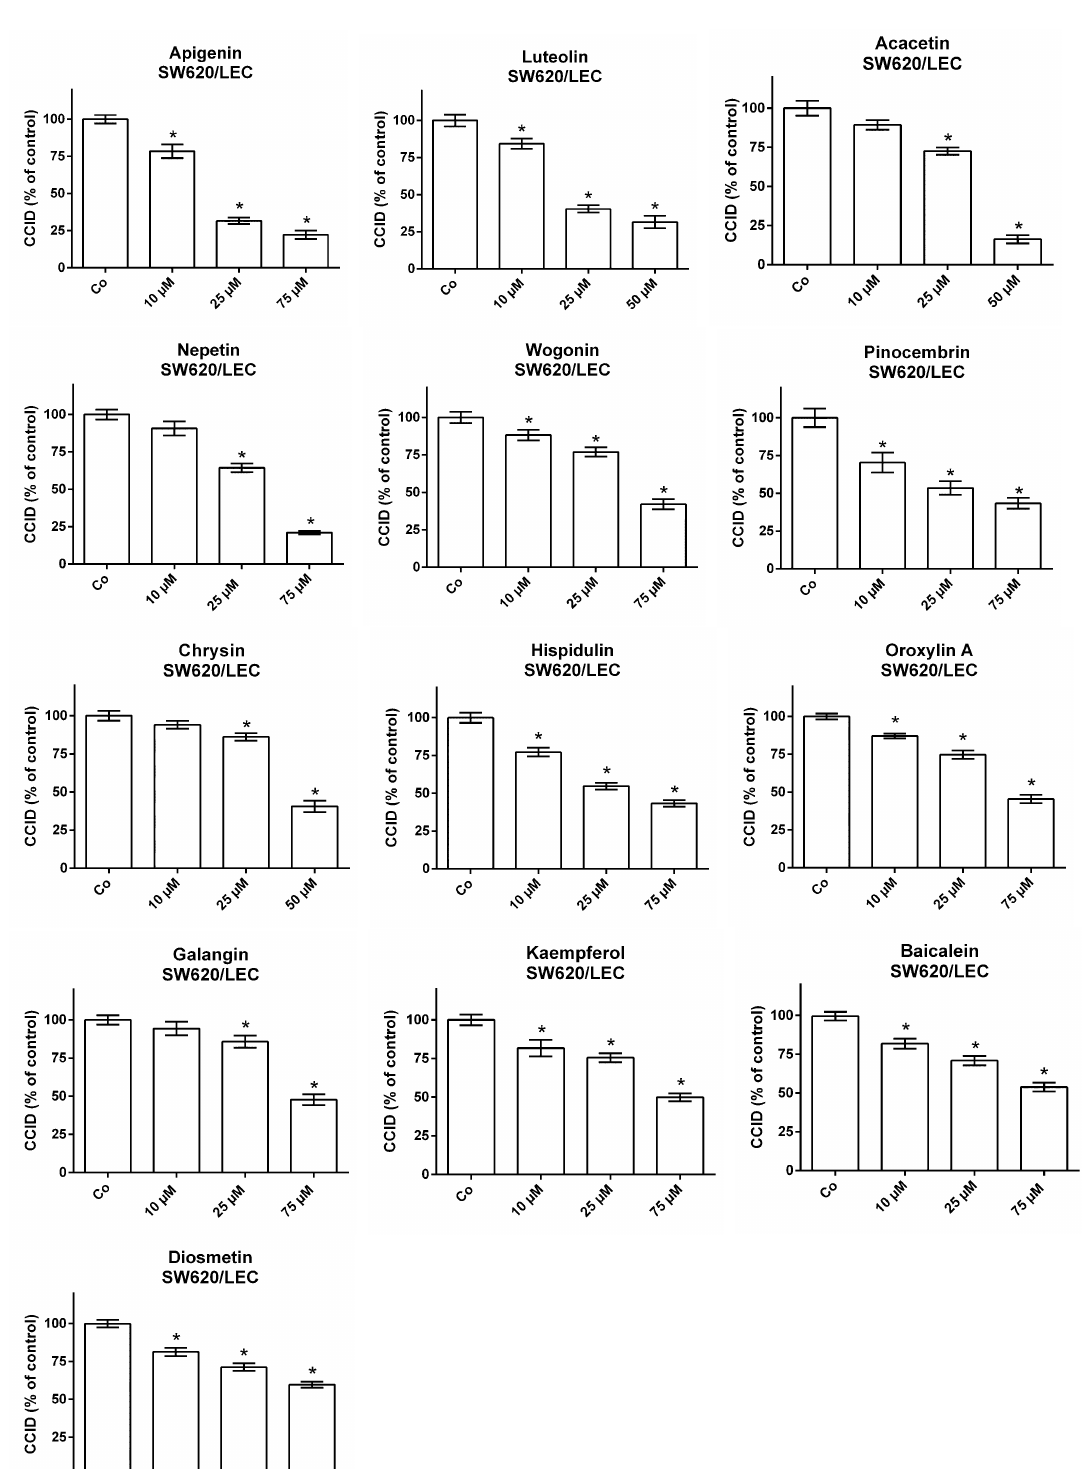
Figure 1. SW620 spheroids were pre-treated for 20 min with solvent (DMSO; Co) or the indicated concentrations of each flavonoid before placement on the lymph endothelial cell (LEC) monolayers and co-cultivation for 4 h. Then circular chemorepellent induced defects (CCIDs) were measured. Three parallel experiments were performed and for each concentration, a total of 15 replicates was analyzed. * p < 0.05.